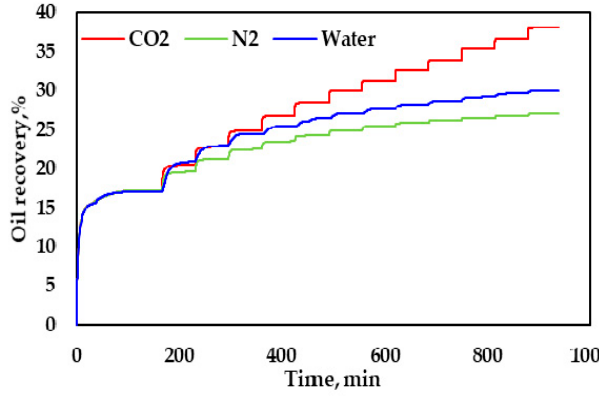
Figure 10. Oil recovery comparison of different fluids (Case-4).